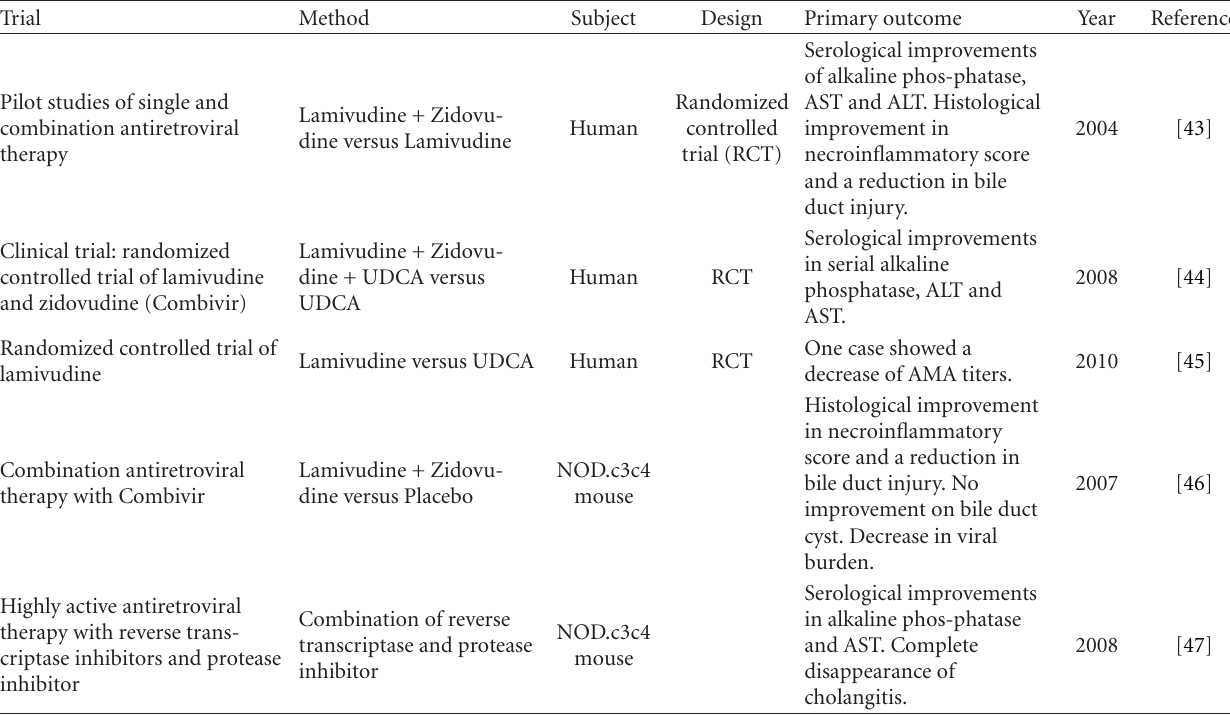
Table 2: Antiviral trials for